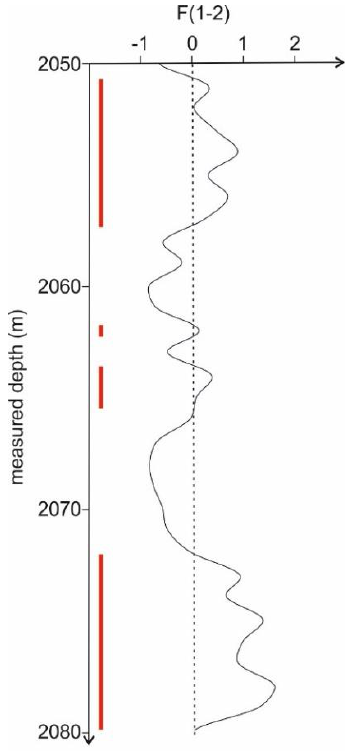
Figure 8. Vertical variation in the F ( 1-2 ) values along the A-1 well. The dashed line separates the undeformed host rock from the faulty rocks (Figure 4a). Red bars indicate the possibly deformed intervals.